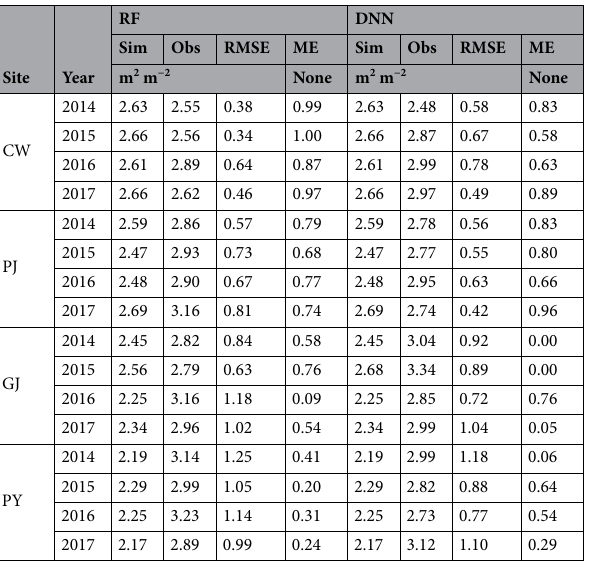
Table 2. Comparison of observed (Obs) and simulated (Sim) LAI values of paddy rice in terms of the root mean square error (RMSE) and Nash–Sutcliffe efficiency (NSE) for the random forest (RF) and deep neural network (DNN) regressors for Cheorwon (CW), Paju (PJ), Gimje (GJ), South Korea and Pyeongyang (PY), North Korea, from 2014 to